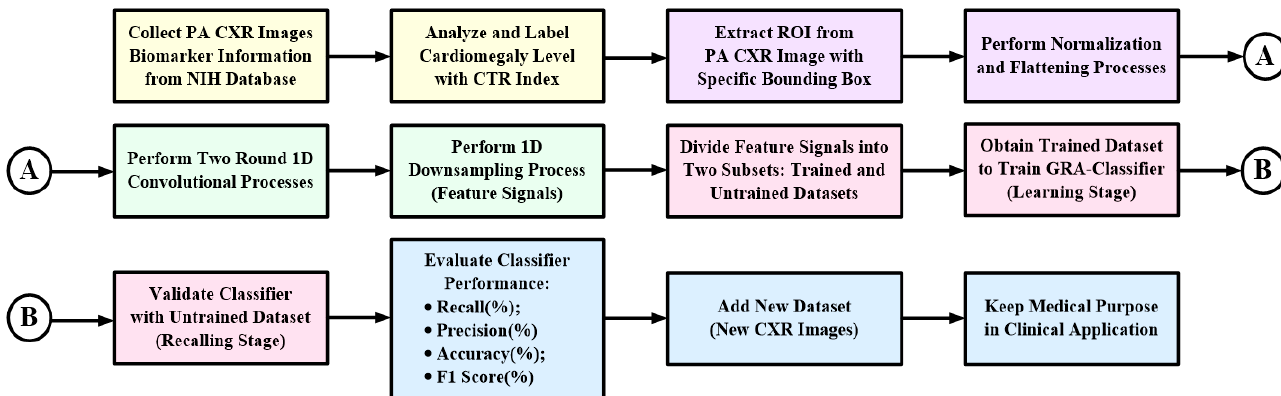
Figure 4. Flowchart of automatic cardiomegaly level screening for multilayer classifier design in clinical application.